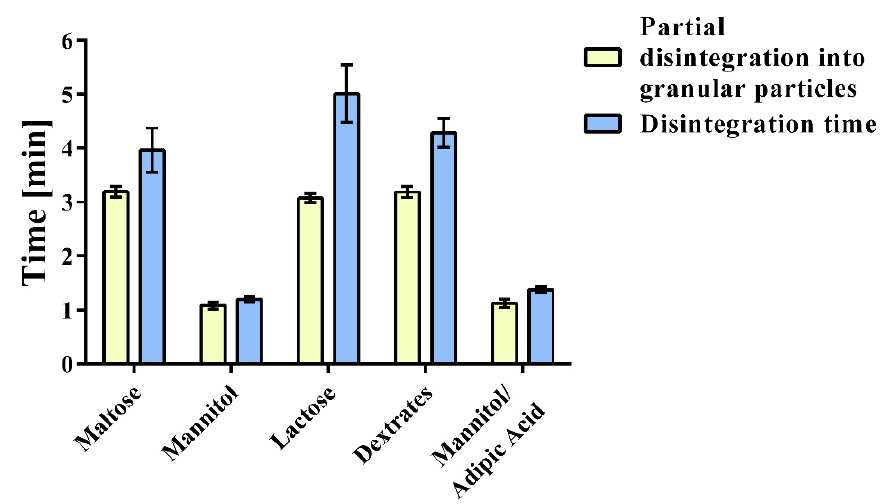
Figure 1. Disintegration time of tablets containing different fillers. Experiments were conducted in a beaker with 200 mL of water as described in the monograph of effervescent tablets in the Ph. Eur. 10.1/0478. Primary and secondary endpoints of disintegration were determined visually. The first measurement was taken when the tablet had partially disintegrated into granular particles (DiG = partial disintegration into granular particles). The second measurement was taken as the endpoint, after the tablet and the particles had disintegrated completely (DT = disintegration).